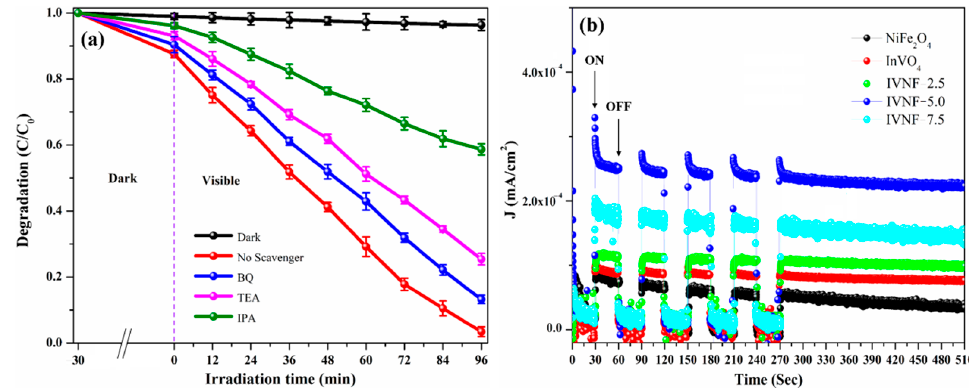
Figure 11. ( a ) Radical quenching experiment for the degradation of TC over IVNF-5.0 nanocomposite, and ( b ) I–t curves of the samples under the ON–OFF